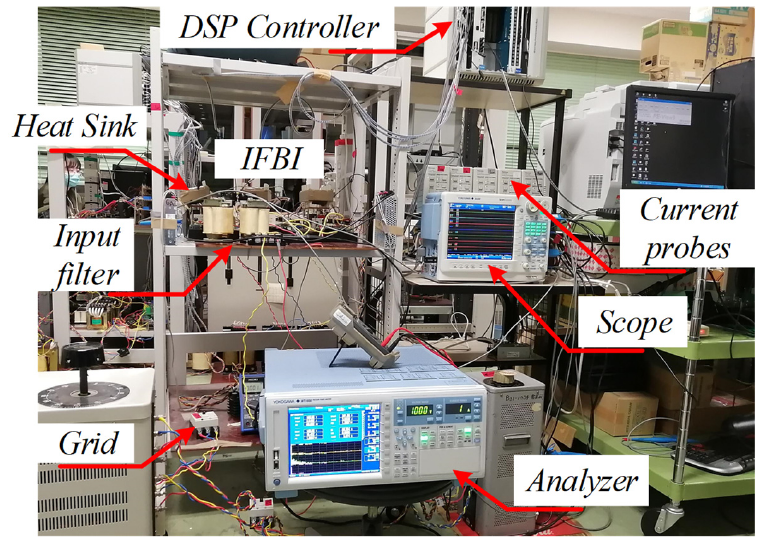
Figure 7. Proposed IFBI photograph. Table 3. IFBI simulation and experimental parameters comparison.